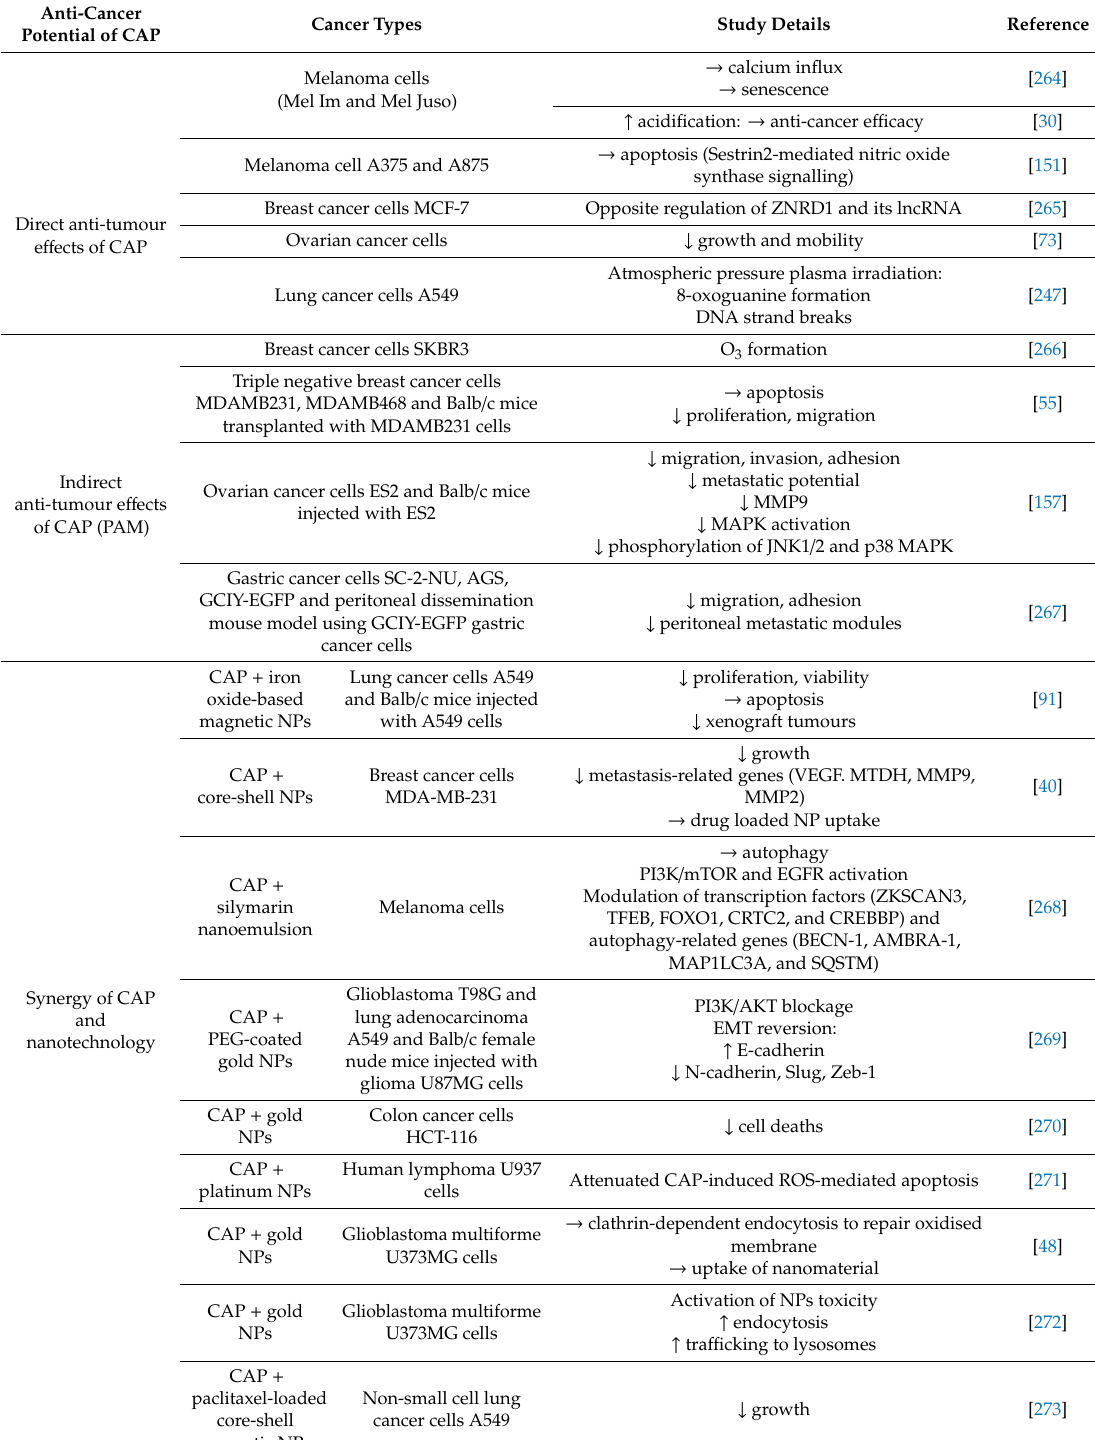
Table 2. A brief overview of anti-cancer e ff ects of